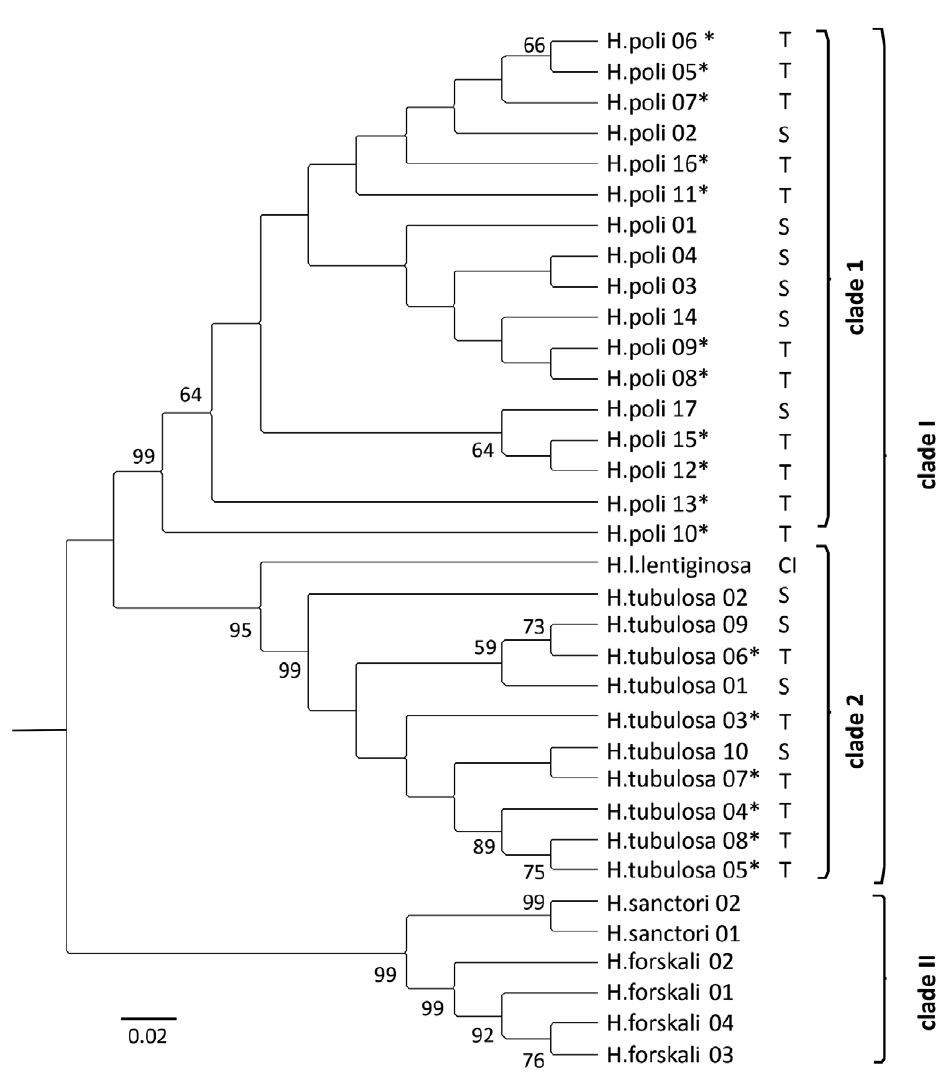
Fig. 4. – DNA sequence analysis of sea cucumbers from the genus Holothuria. Neighbour-joining tree analysis of 500 bp COI fragments based on p-distance. The bootstrap consensus tree inferred from 10000 replicates. Only bootstrap value branches exceeding 50% are indicated. The p distances were computed using the Kimura 2-parameter method and they were in the units of the number of base substitutions per site. Analyses were conducted in MEGA7. H, Holothuria ; *, doubtful species; T, Tunisia; S, Spain; C-I, Canary